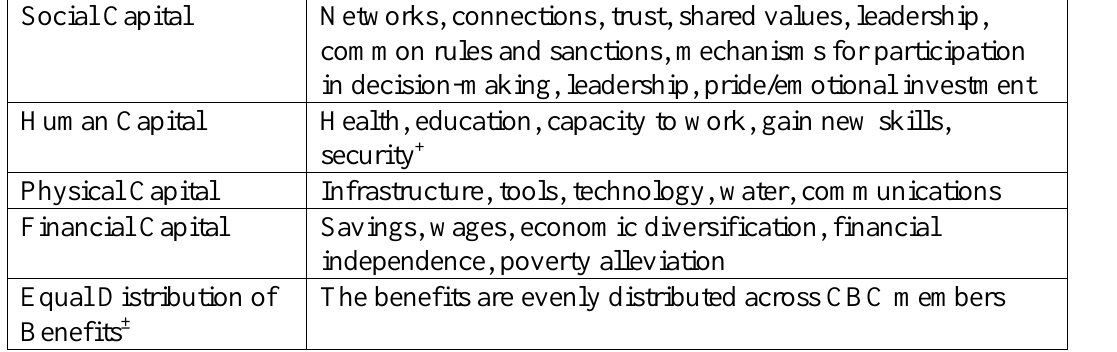
Table 1.2. Description of capital assets used to code social outcomes in the review (adapted from Plummer and Armitage, 2007 and DfID, 1999) Social